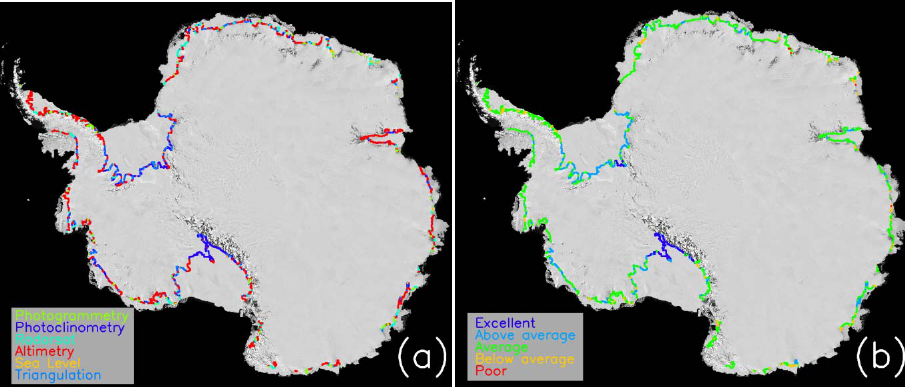
Figure 7. The ASAID hydrostatic line. (a) Colored lines represent the DEM source of selected elevation values. The corresponding percent frequencies of occurrence are: photogrammetry (green, 4%); photoclinometry (dark blue, 37%); Radarsat (cyan, 16%); altimetry (red, 38%); sea level (orange, 0.3%); and triangulation (light blue, 5%). (b) Colored lines represent the confidence in the selected elevations. The corresponding percent frequencies of occurrence are: Excellent (dark blue, 4%); Above Average (cyan, 32%); Average (green, 59%); Below Average (orange, 4%); and Poor (red, 0.1%).